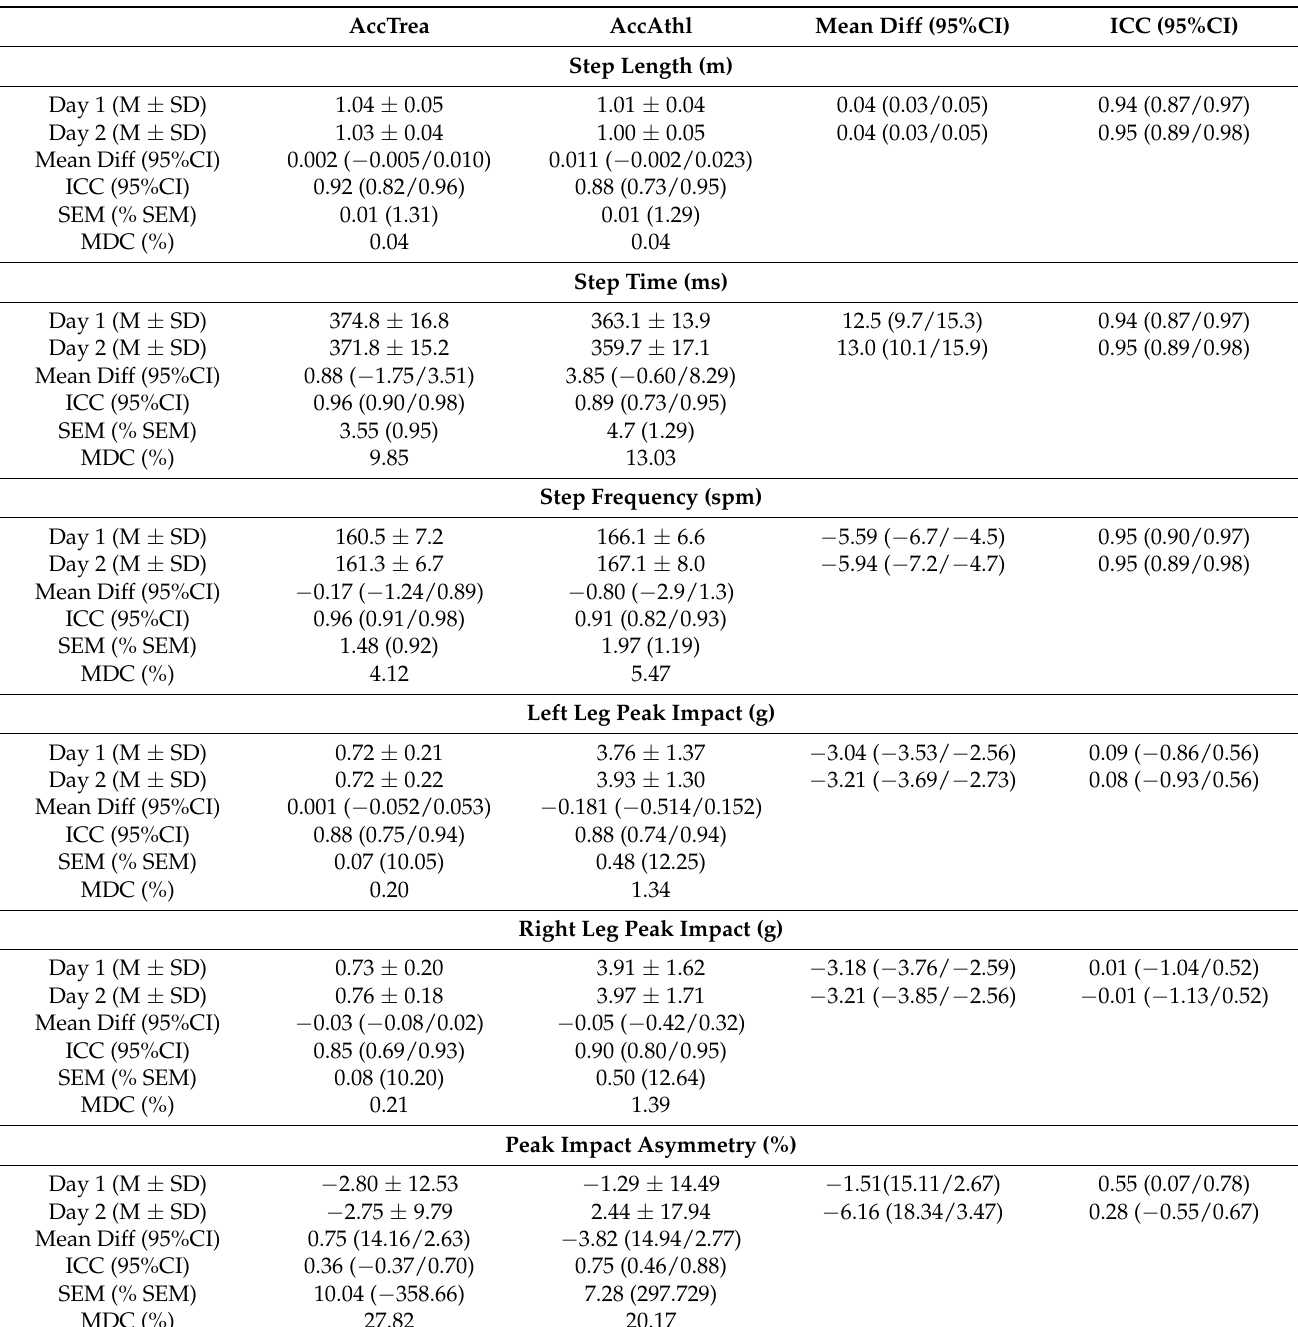
Table 3. Validity and reliability of an instrumented treadmill with an accelerometry system for assessment of spatio-temporal parameters and impact